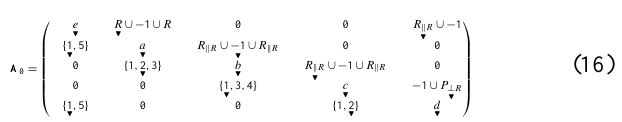
any configuration